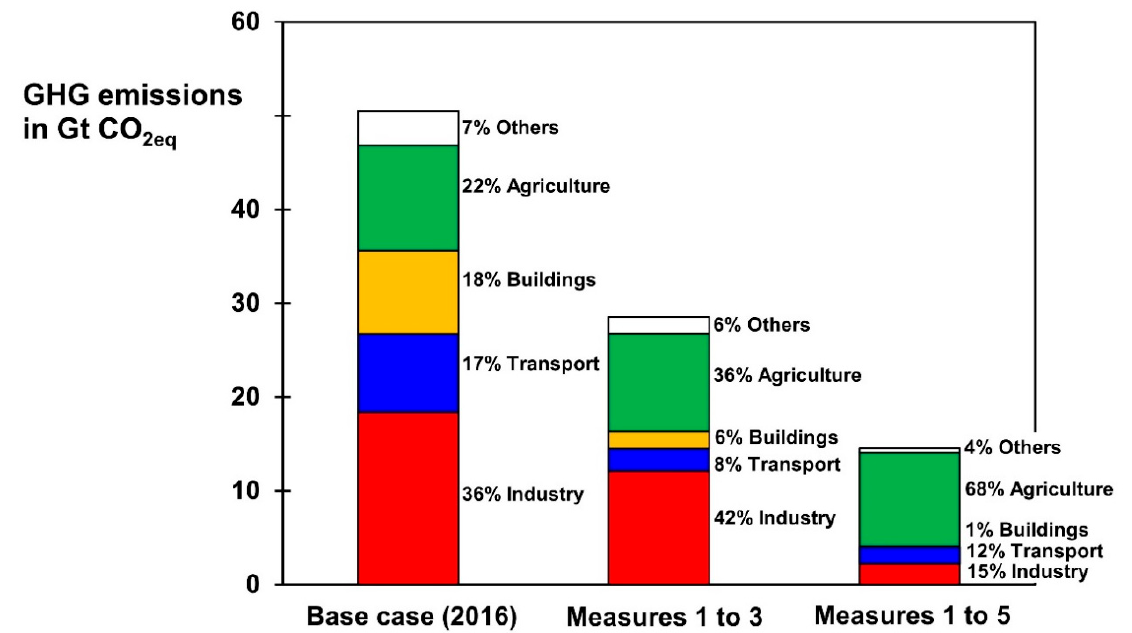
Figure 4. Global GHG emissions and shares of different sectors in the base case (2016) and if measures 1 to 3 or 1 to 5 are taken (constant global population and prosperity).